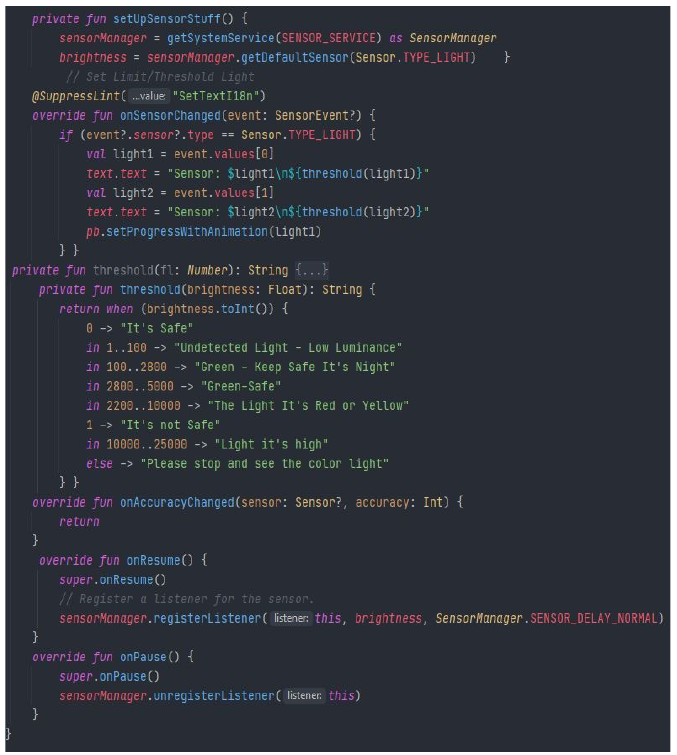
Figure 14. Structure of light intensity processing ambient sensor and setting safety thresholds.